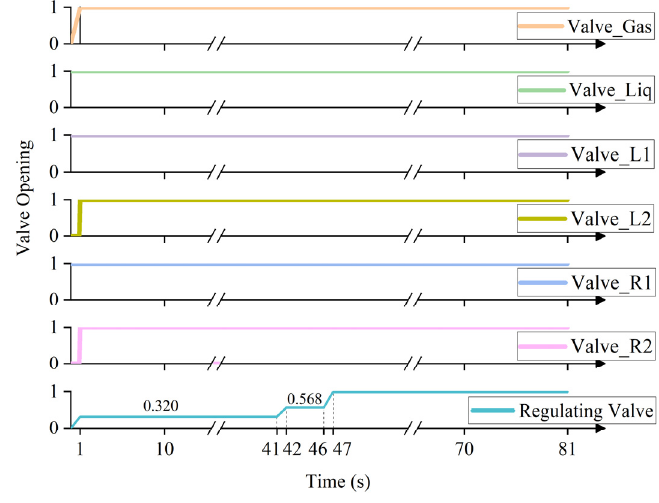
Figure 3. Working sequence of synchronous start (Scheme SYNC).